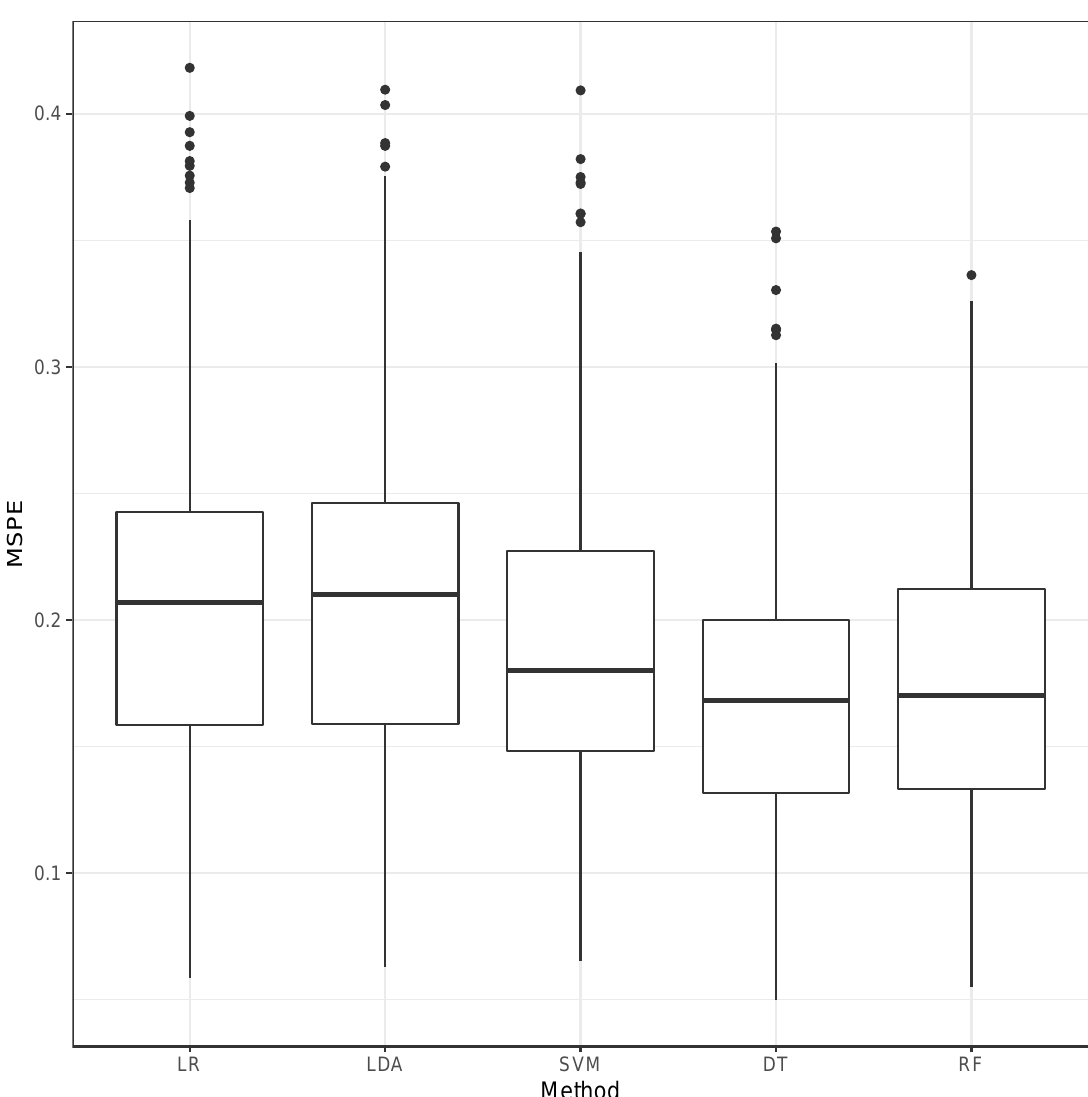
Figure 7. Boxplots of the MSPE for the five classification methods.